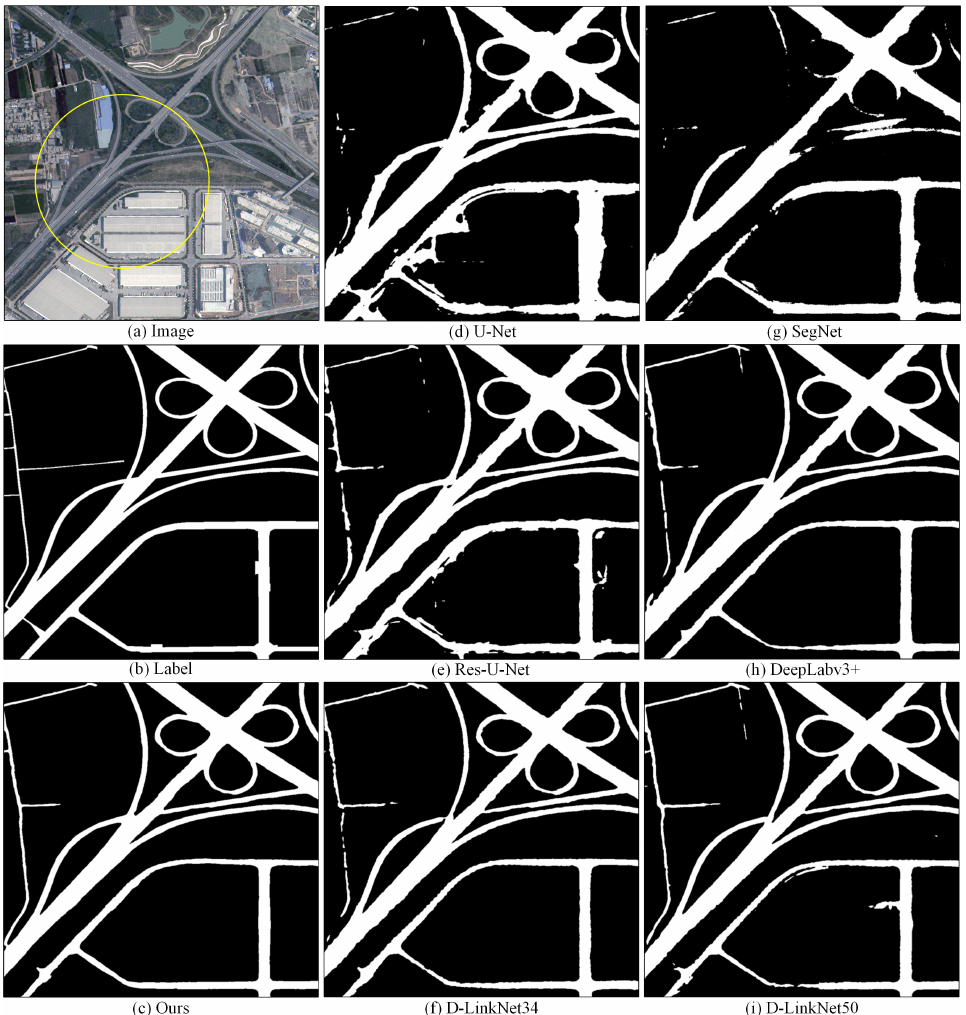
Figure 14. Local detail comparison on Huawei dataset. Subparts ( d – i ) are the results of the related methods corresponding to the area in the original image ( a ) marked with yellow. Subparts ( b , c ) are the ground truth and our method.